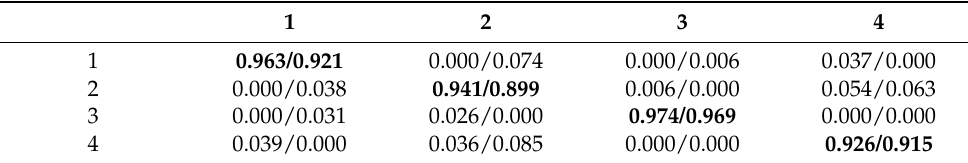
Table 5. Average latent class probabilities for most likely latent class membership (row) by latent class (column) (SAS/TRAS).